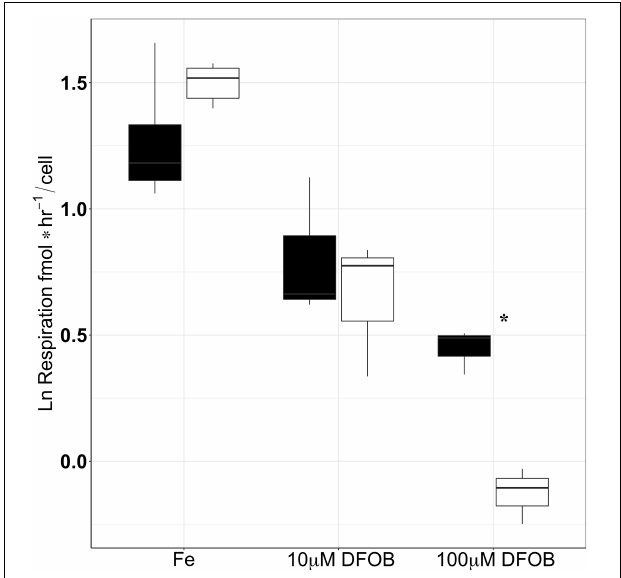
FIGURE 5 | Growth rates of wt (black) and (cid:49) icl (white) under different levels of Fe-limitation (Fe-replete, 10 µ M DFOB, 100 µ M DFOB) performed in triplicate. The natural logarithm (ln) was used in order to account for a skewed data set. Black dots represent outliers while significant differences between wt and (cid:49) icl are marked with an asterisk, where ∗ p < 0.05, ∗∗ p < 0.005, ∗∗∗ p < 0.0005.